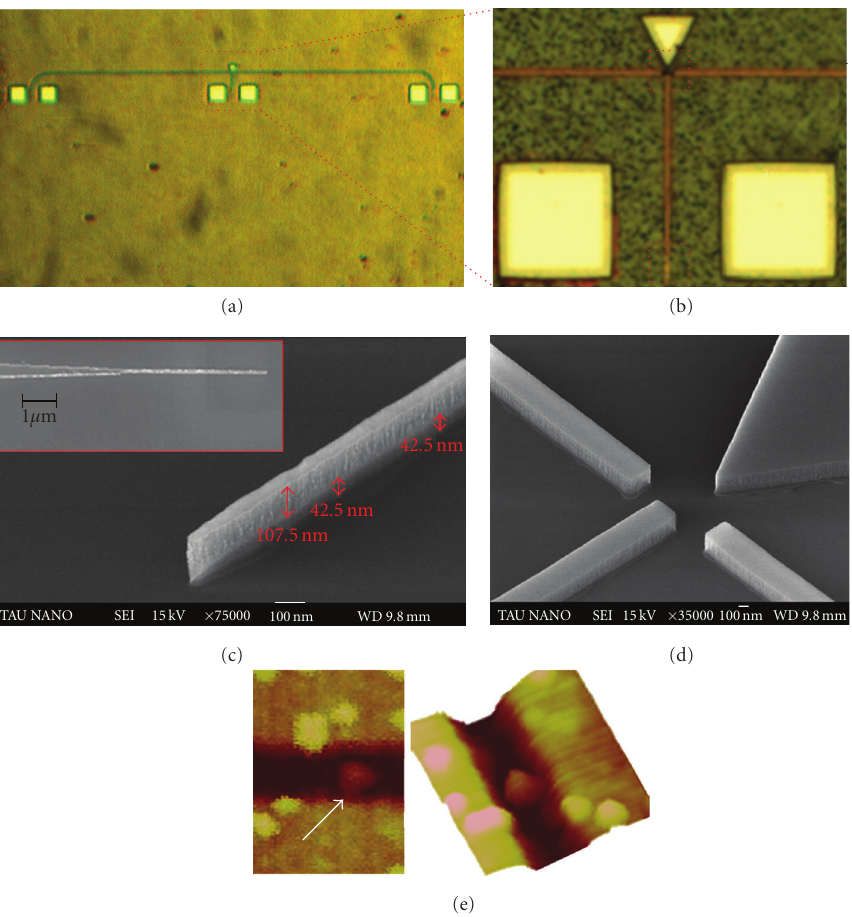
Figure 4: Fabricated “Y coupler.” (a) Top view microscopic image of the overall fabricated device. (b) Enlarged image shows the input waveguide which splits into a pair of waveguides; (c) and (d) show SEM images of the lower and upper encompass areas (shown in Figure 4(b)) that define the coupling of light from fiber to the silicon waveguide and the fabrication of the T-junction itself, respectively. (e) Placing the particle in the slit (the particle is marked with white arrow). Left part is an upper view of the particle and the right part is the 3D